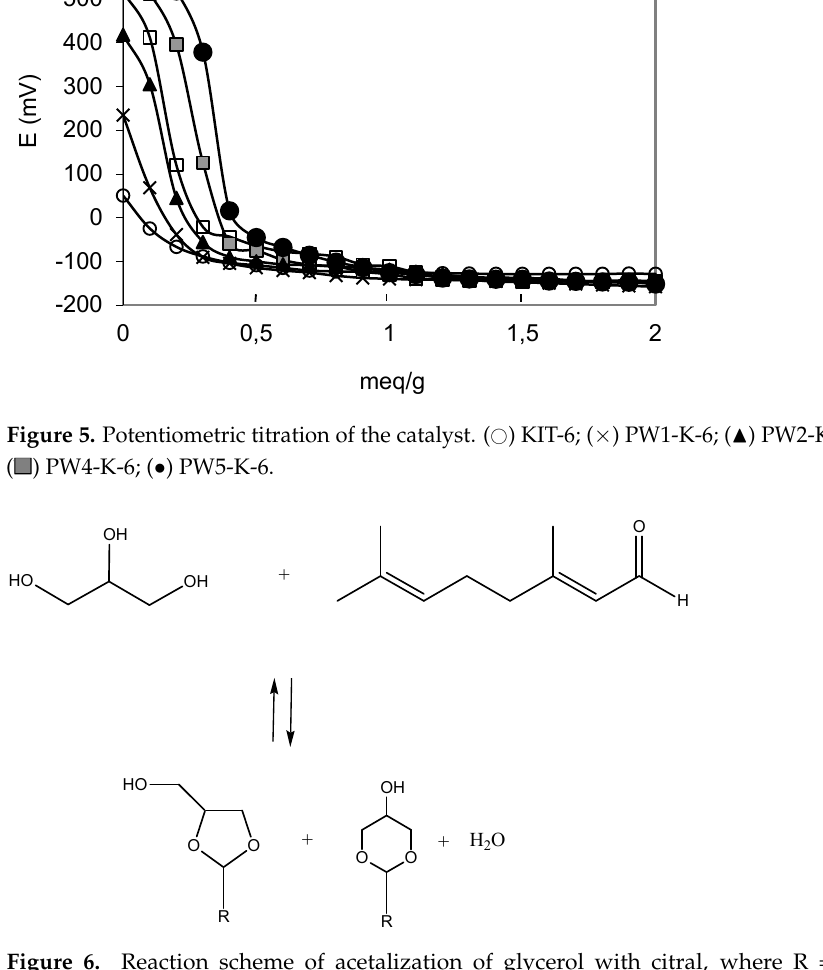
Figure 6. Reaction scheme of acetalization of glycerol with citral, where R = - CH=C(CH 3 )CH 2 CH 2 CH=C(CH 3 )(CH 3 ).